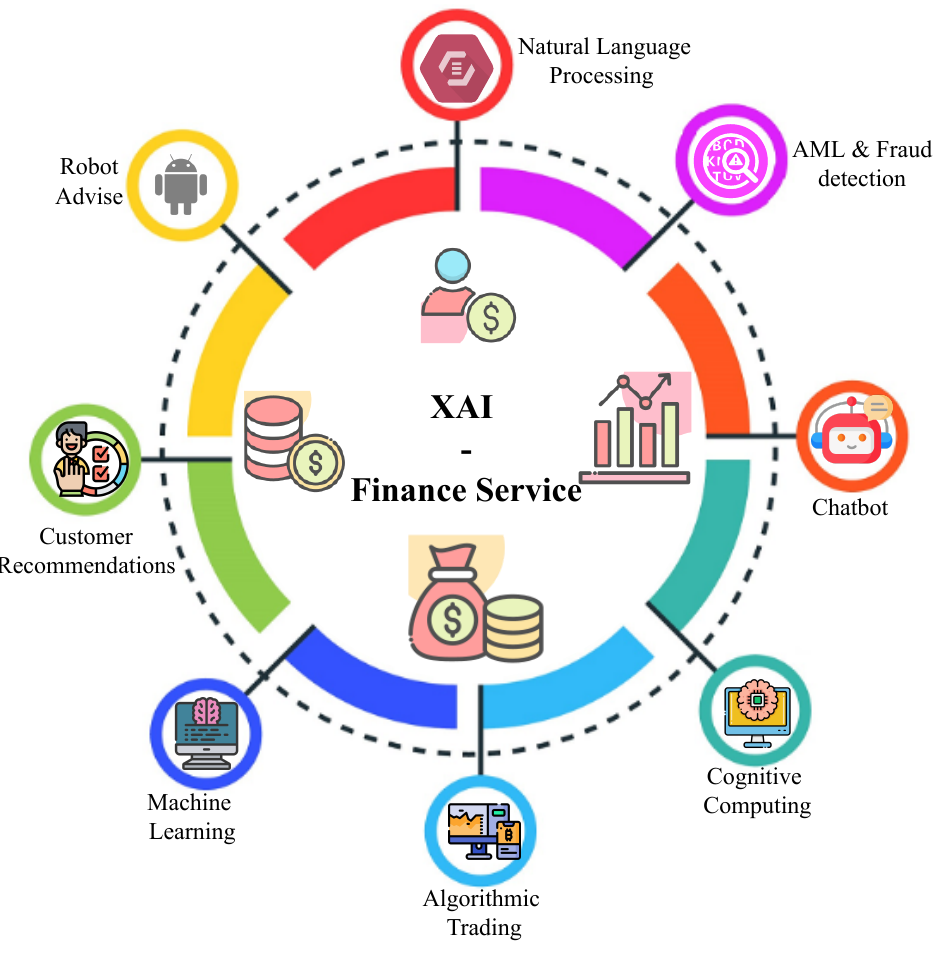
Figure 7. XAI in Financial